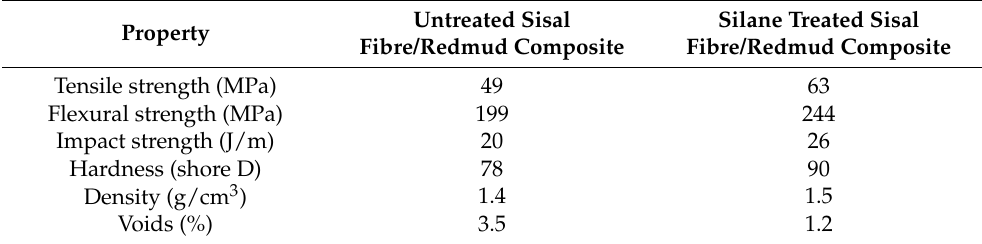
Table 1. Properties of the fabricated composite structure [23].